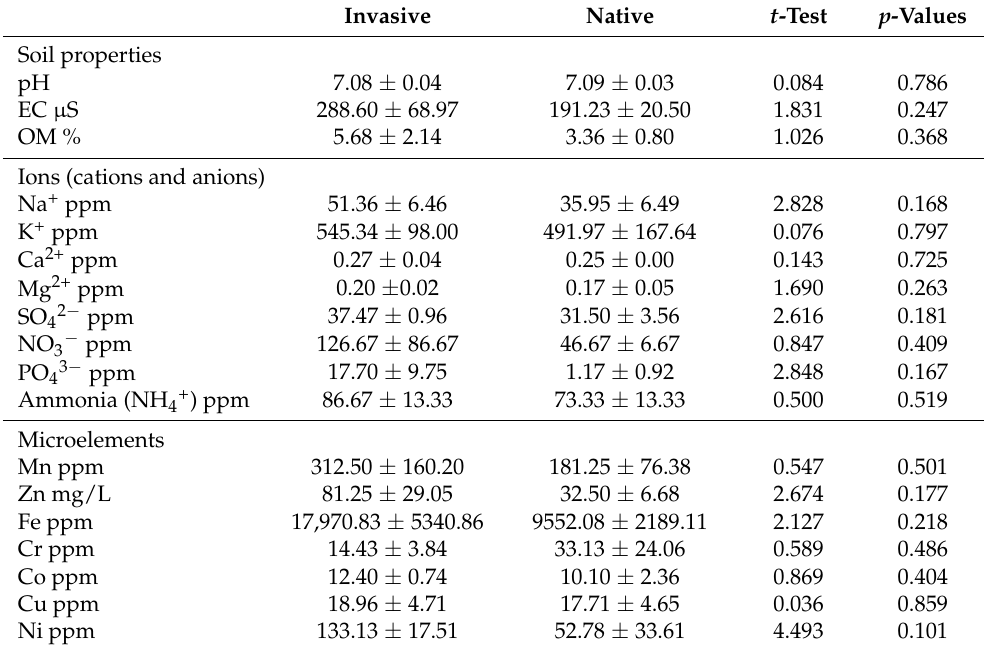
Data represented as means ± SE, n = 6. Table 4. Soil properties, ion concentrations, and microelement concentrations of soils in stands invaded by Opuntia ficus-indica and adjacent stands with native vegetation in southwest Saudi